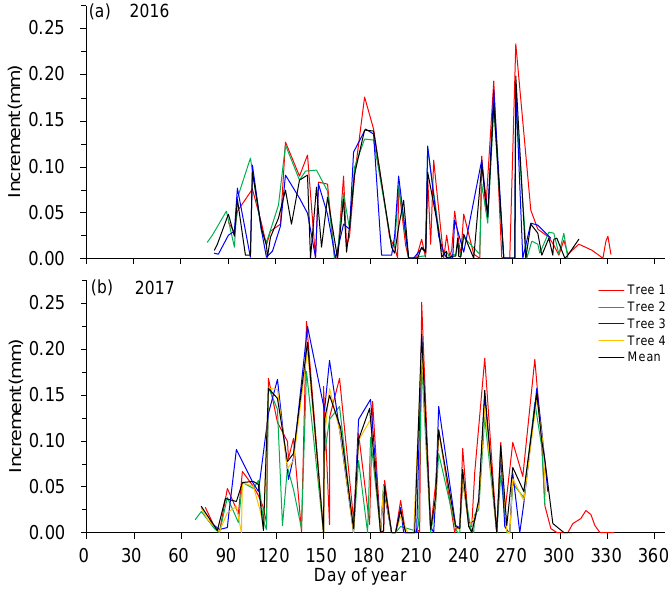
Figure 5. Time series of stem increments of four trees extracted for the growing periods of ( a ) 2016 and ( b ) 2017.